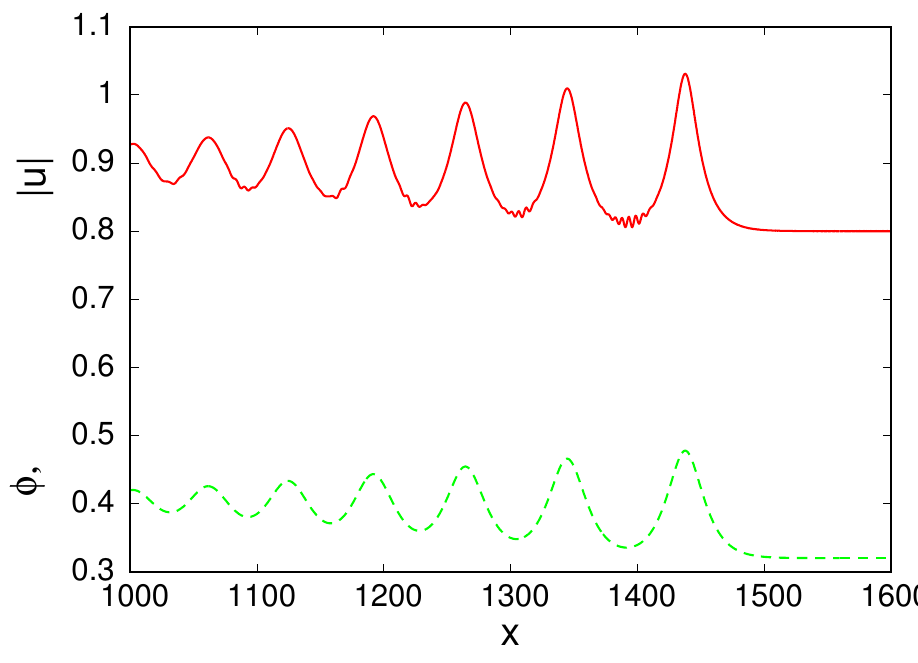
Figure 5. Numerical solution of nematic Equations (11) and (12) in PDSW regime at z = 1500 for initial condition (13) with u + = 0.8 and u − = 1.0. Red (solid) line: | u | ; green (dashed) line: φ . Here, ν = 200 and q =